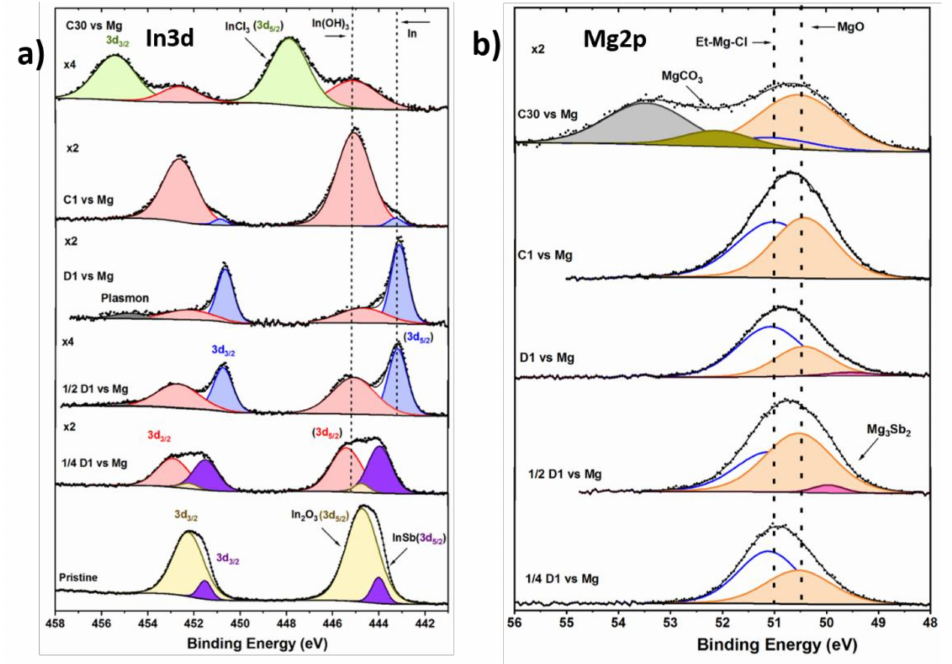
Figure 4. ( a ) In3d and ( b ) Mg 2p core peaks spectra of the InSb electrode cycled in EtMgCl–Et2AlCl/THF electrolyte vs. Mg. All spectra were calibrated by considering the adventitious carbon peak (C-C/C-H) at 284.8